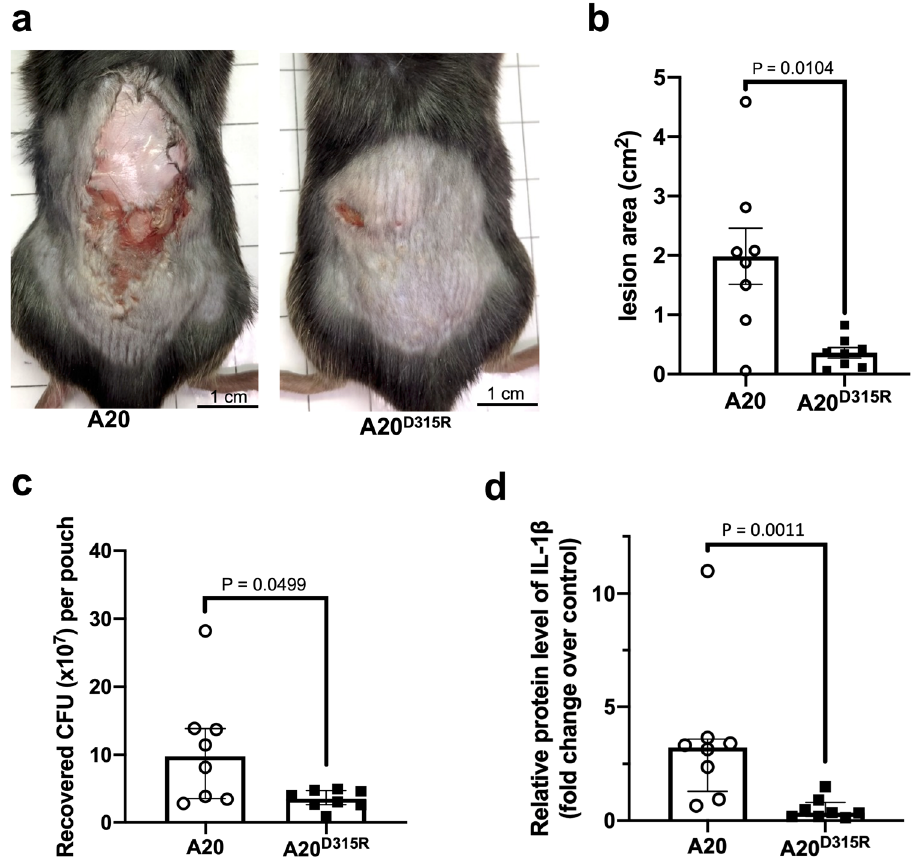
Fig. 5 GAS-infected mouse model. a Representative images of skin lesions of A20- or A20 D315R -infected mice at 24-hour post-infection. Scale bars: 1 cm. b Quanti fi cation of the skin lesion sizes. The area of necrotic skin lesions at 24-hour post-infection was quanti fi ed by analyzing the lesion images. There were 8 mice ( n = 8) used for each infection group. c Bacterial counts in air pouch exudates. The bacterial numbers of A20 and A20 D315R were counted by a CFU-based assay. d Quanti fi cation of IL-1 β . The levels of IL-1 β in the GAS-infected skin tissues are presented as the ratio of the level of IL-1 β related to that of β -actin. The quantitative results are presented as median with interquartile range ( n = 8). The statistical signi fi cance was evaluated by a two-tailed Mann-Whitney U